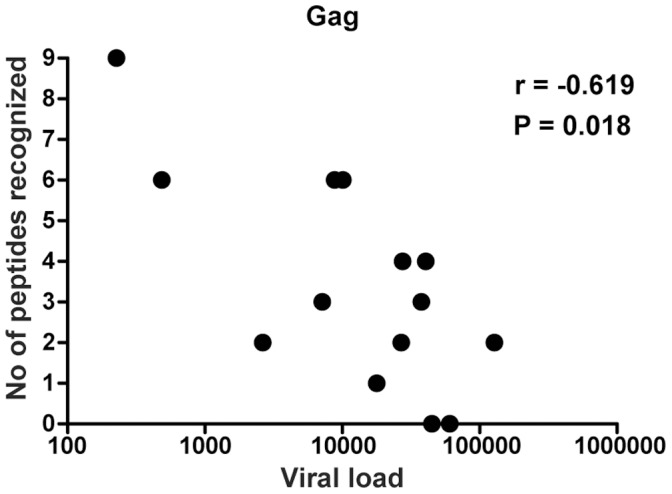
Association between the breadth of Gag-specific CD4+ T cells and HIV viremia.Correlation between CD4+ T cells targeting multiple Gag peptides and viral load in viremic subjects using the Spearman non-parametric test. Similar correlation and significance was obtained excluding subject THS-15, who had low-grade viremia and documented poor treatment adherence.